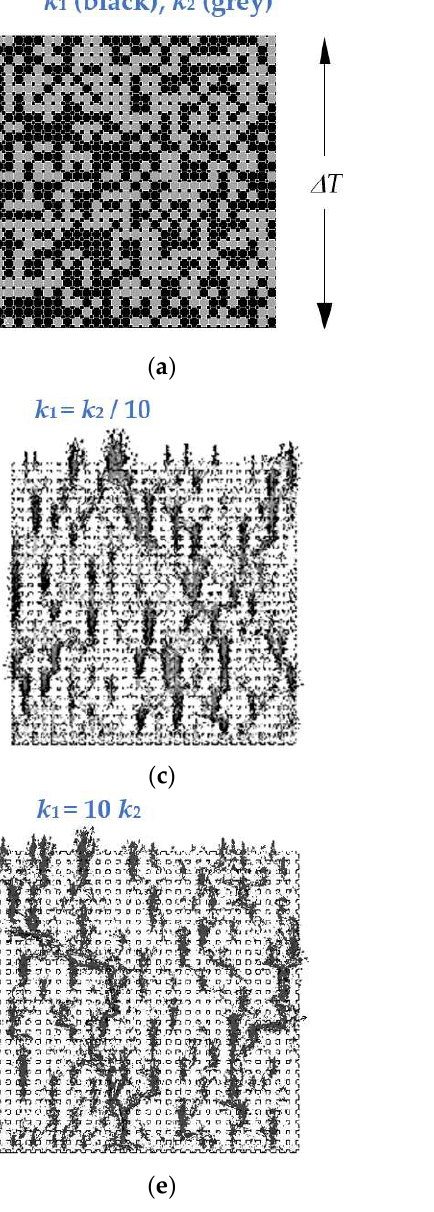
Figure 3. Heat flux for network for a variety of k 1 / k 2 ratios. ( a ) Original network, k 1 (variable, black), k 2 = 1 W m − 1 K − 1 (constant, grey), ( b ) k 1 = k 2 /1000, ( c ) k 1 = k 2 /10, ( d ) k 1 = k 2 , ( e ) k 1 = 10 k 2 , ( f ) k 1 = 1000 k 2 .